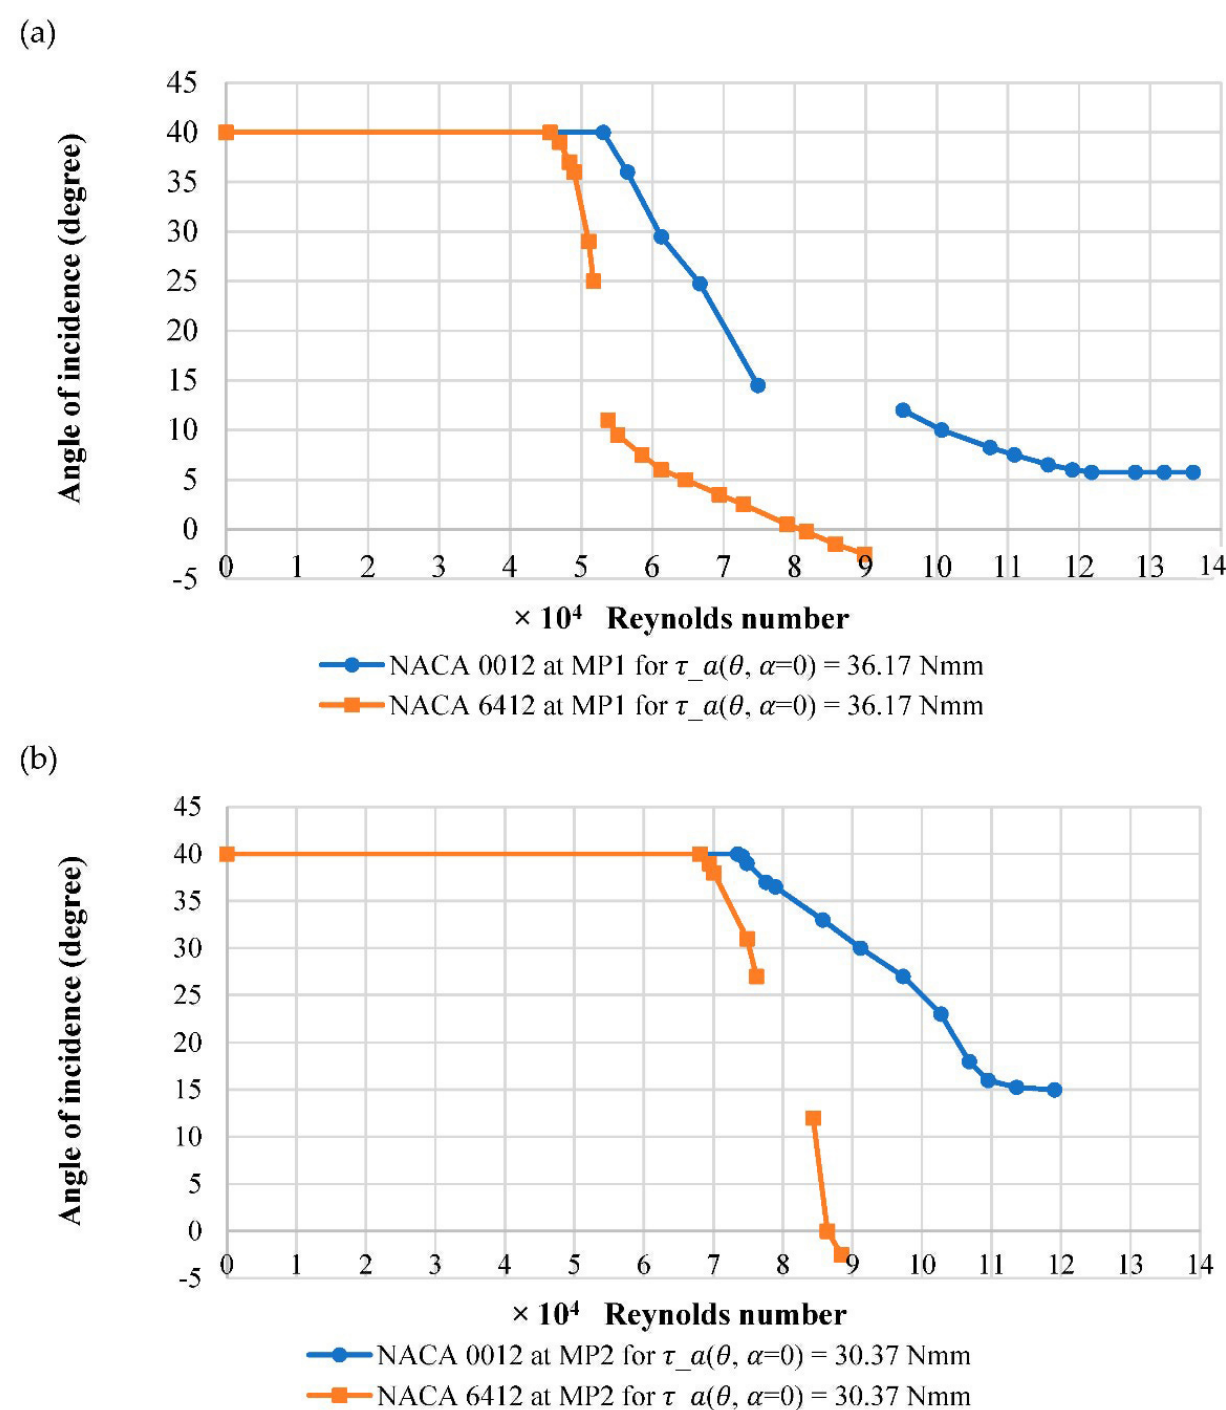
Figure 10. Effect of airfoil shape at ( a ) MP1 and ( b )